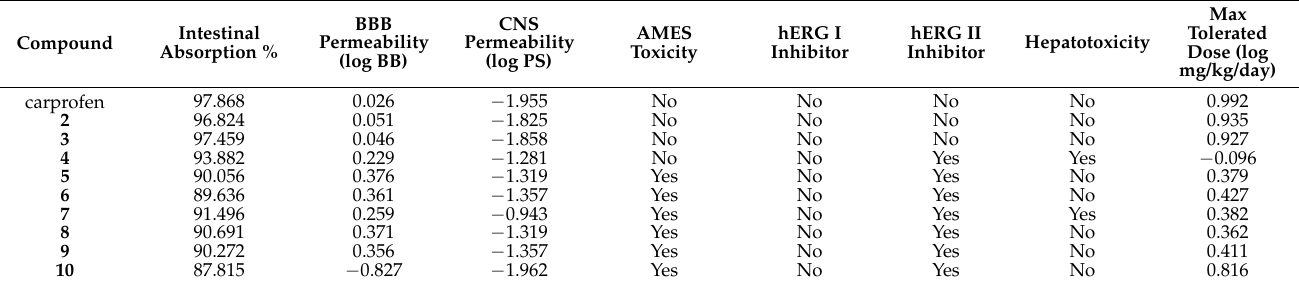
predictions for compounds 2 – 10 and